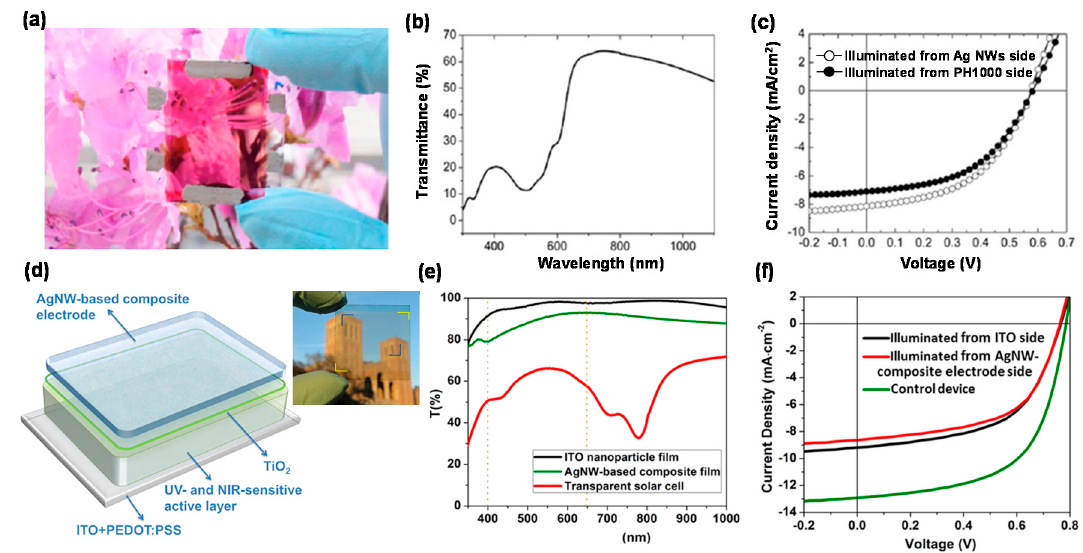
Figure 4. ( a ) A photograph of a typical P3HT:PCBM-based STOSC; ( b ) Optical transmittance spectrum of a STOSC with Ag NWs- and PH1000-based TCEs; ( c ) J - V characteristics of the STOSCs illuminated through the Ag NWs and the PH1000 electrodes. Reprinted with permission from [42]. Copyright 2014 ACS. ( d ) Schematic and photograph of the device architecture for solution-processed visibly-transparent OSCs; ( e ) Transmission spectra of the pristine ITO nanoparticle film, the Ag NW-based composite transparent electrode, and a STOSCs; ( f ) J - V characteristics of the transparent device (illuminated from ITO side or Ag NW composite electrode side) and the control device. Reprinted with permission from [43]. Copyright 2012 ACS.